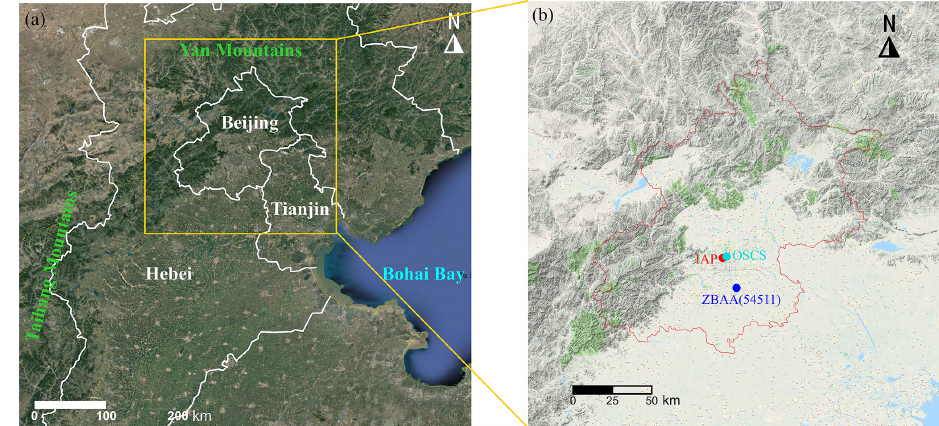
Figure 1. Local topography of Beijing and of its surrounding area (a) . The locations of observation sites in Beijing (b) – red circle: IAP (lidar); blue circle: ZBAA radiosonde observation station; cyan circle: pollution observation station (OSCS), which is positioned approximately 2km northeast of the lidar. Beijing is a densely populated city covering an area of approximately 396km 2 . Both maps were obtained from © Google Maps. Table 1. Daily average data for six major air pollutants in Beijing measured during a period of heavy pollution from 14 to 23 December 2016: PM 2 . 5 , PM 10 , NO 2 , SO 2 and O 3 (µgm − 3 ); CO (mgm − 3 ). Data sources: http://beijingair.sinaapp.com/ (last access: 28 August 2019). According to the “Technical Specification for Air Quality Index (HJ 633-2012)” issued by China’s National Environmental Protection Agency, air pollution levels can be divided into five levels based on PM 2 . 5 concentrations, i.e., good (0–75µgm − 3 ), slightly polluted